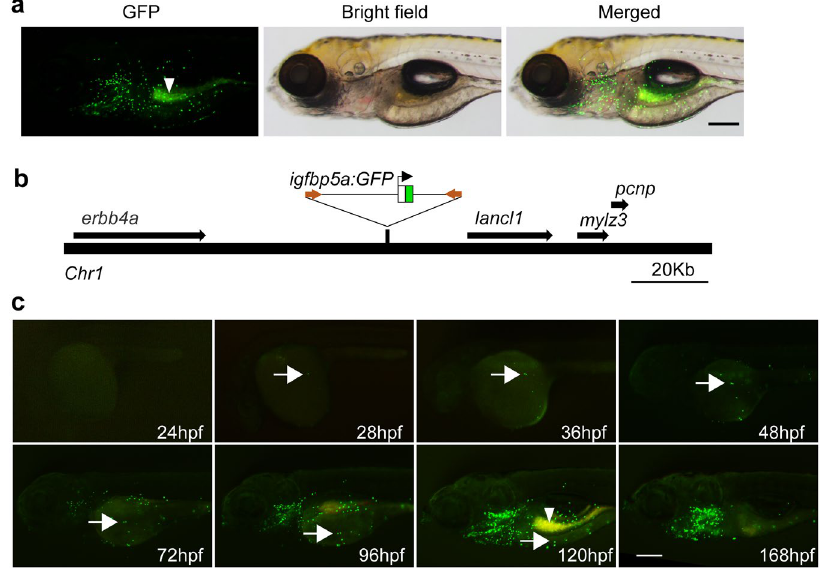
Figure 3. Characterization of the stable Tg ( igfbp5a : GFP ) fish line. ( a ) Lateral view of a 120 hpf transgenic Tg ( igfbp5a : GFP ) larva. The GFP-labeled cells are located in the yolk sac region and gills. Auto-fluorescence is indicated by an arrowhead. Scale bar = 0.2 mm. ( b ) Schematic diagram showing the genomic integration site. ( c ) Developmental pattern of GFP-labeled cells. Arrows indicate the emergence of GFP-positive cells and its subsequent location in the indicated stages. Auto-fluorescence is indicated by an